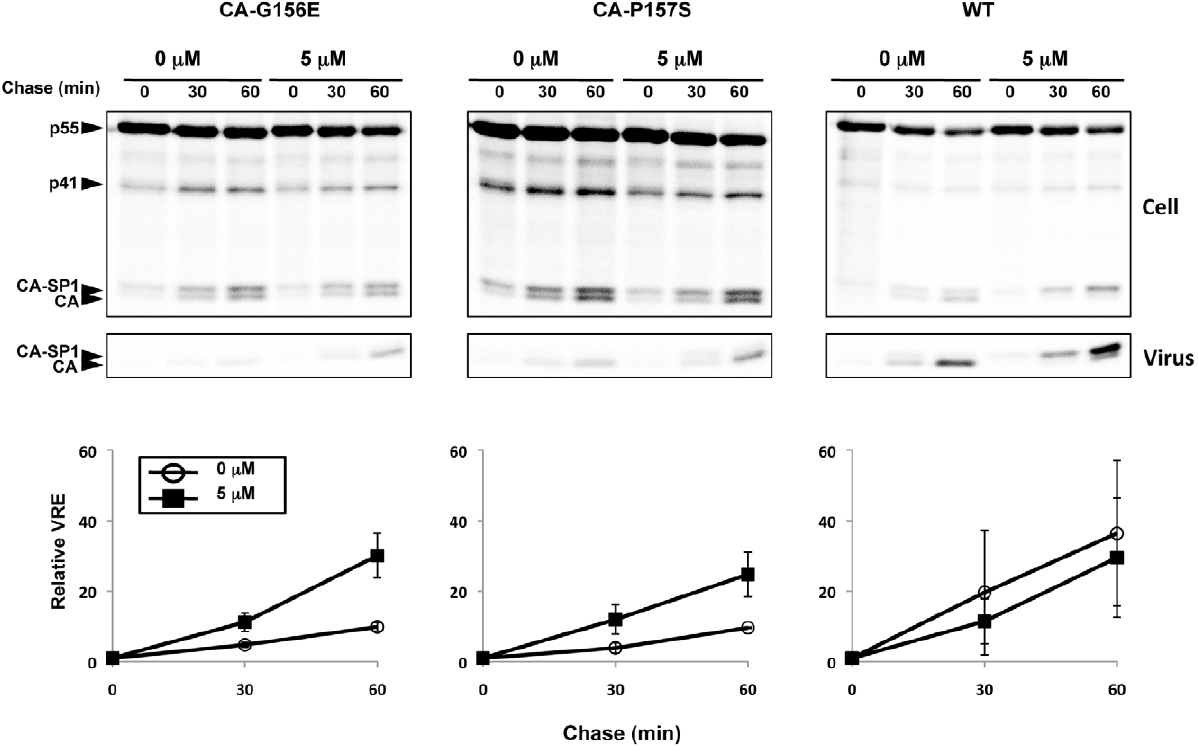
Figure 12. PF-46396 can trigger the release of compound-dependent MHR mutants. 293T cells were transfected with WT or mutant pNL4- 3 molecular clones. At 24 h posttransfection, cells were starved for 30 min in Met/Cys-free medium and metabolically labeled with [ 35 S]Met/Cys for 20 min. Cells were divided into two fractions, washed, and resuspended in medium containing no or 5 m M PF-46396. Each fraction was further divided into three aliquots and incubated at 37 u C for the indicated chase times. Cell and viral lysates were radioimmunoprecipitated. Positions of Pr55 Gag (PrGag), Pr41 Gag (p41), CA-SP1, and CA are indicated. Graphs in the lower panels show phosphorimager-based quantification of relative virus release efficiency (VRE) calculated as described in the Fig. 6 legend. Error bars indicate SD; N=3.